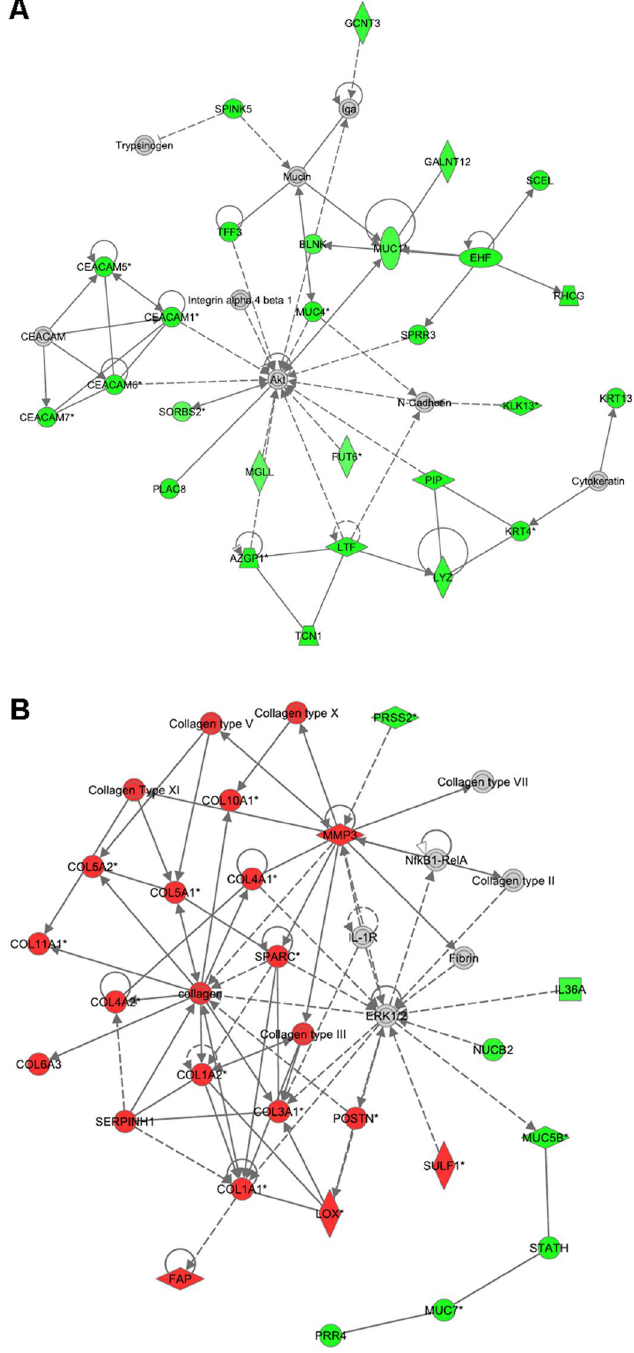
Figure 3. Top networks of differentially expressed genes in PT vs .N as identified by Ingenuity Pathway Analysis show strong association to cancer and connective tissue disorders. For network analyses a threshold of log 2 FC > |1.5| with a p-value < 0.0001 (corresponding to a FDR of 0.003) was used, giving an overview of involved genes within the networks and their differential expression. Node colour indicates up-regulated (red), down-regulated (green) or not significantly changed according to threshold (grey) genes. Lines and arrows between nodes represent direct (solid lines) and indirect (dashed lines) interactions between molecules. All edges are supported by at least one reference from the literature or from canonical information stored in the Ingenuity Knowledge Base. Node shapes represent functional classes of gene products: square → cytokine, triangle → kinase, rectangle → nuclear receptor, concentric circle → group or complex, vertical diamond → enzyme, horizontal diamond → peptidase, trapezium → transporter, vertical ellipse → transmembrane receptor horizontal ellipse → transcription regulator, circle → other. ( A ) Top 01 significant PT vs .N, network (Cellular Development, Infectious Disease, Cancer) contains 27 focus genes. ( B ) Top 02 significant PT vs .N network (Connective Tissue Disorders, Dermatological Diseases and Conditions, Cellular Assembly and Organization) contains 24 focus